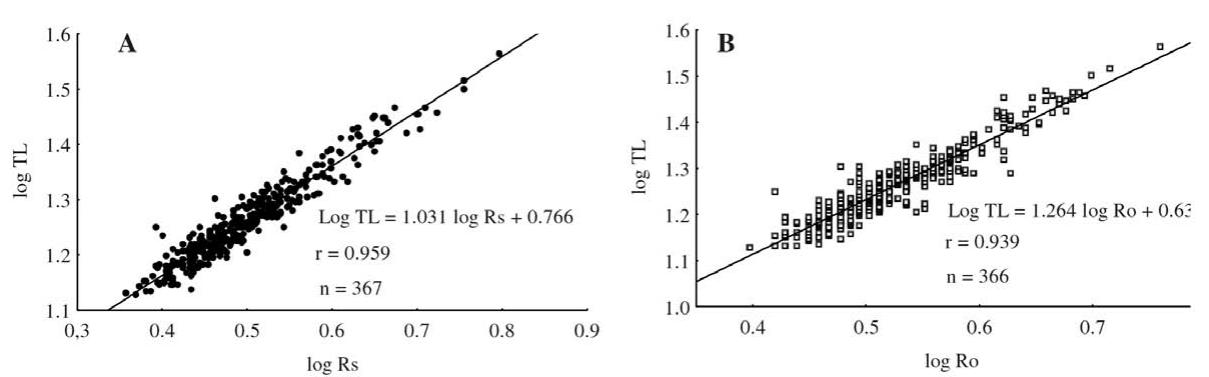
Fig. 3. – Relationships between scale (A) or otolith (B) radius and total length (TL) in cm for Spondyliosoma cantharus of the Gulf of